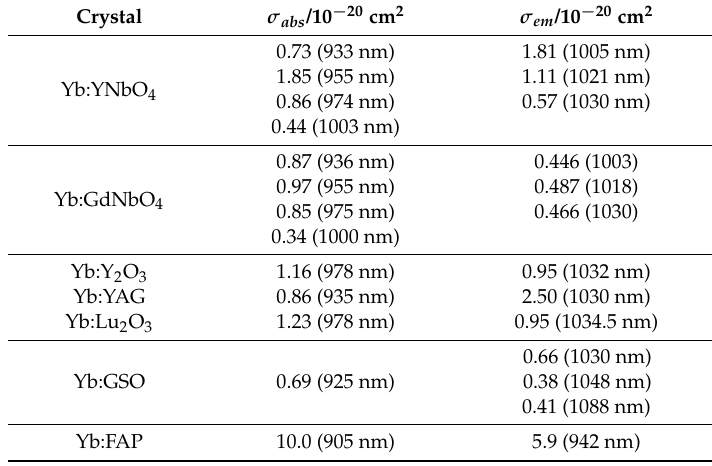
Table 6. Absorption and emission cross-sections for Yb:YNbO 4 , Yb:YNbO 4 , and some other Yb 3+